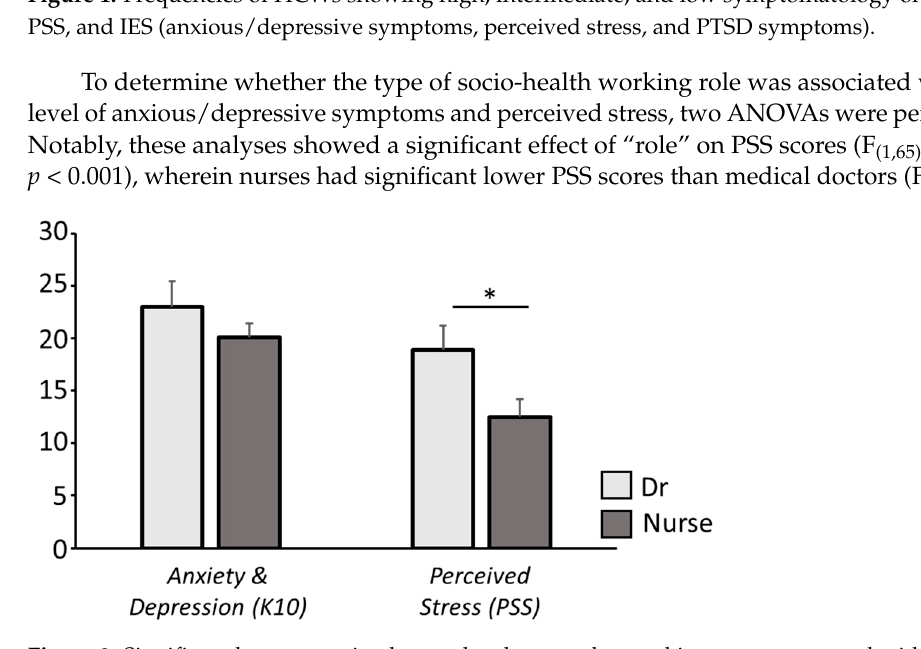
Figure 2. Significant lower perceived stress levels were observed in nurses compared with medical doctors. * p < 0.05.